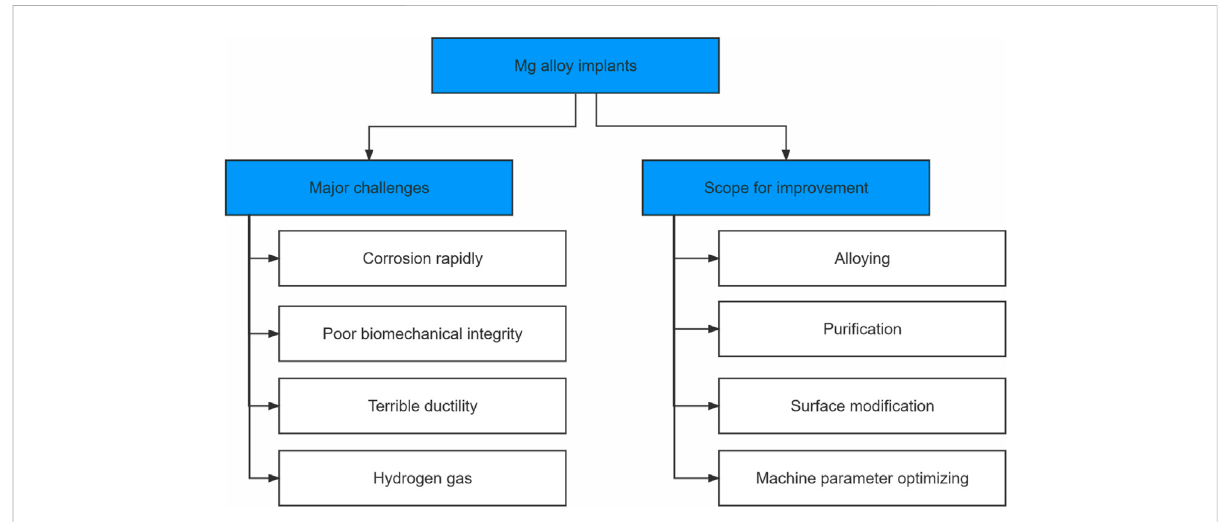
FIGURE 8 Flowchart showing the challenges and scope for improvement of Mg-alloy